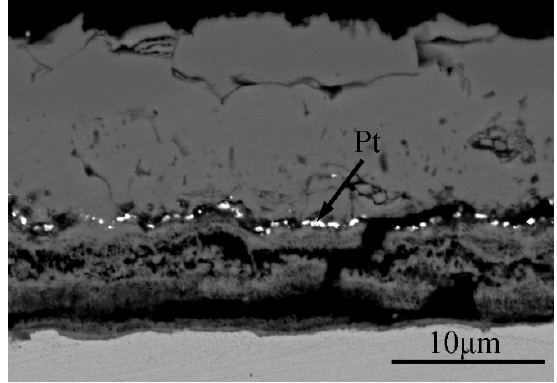
Figure 14. SEM backscattered electron image of the oxide scale obtained at 900 °C for 30 min.